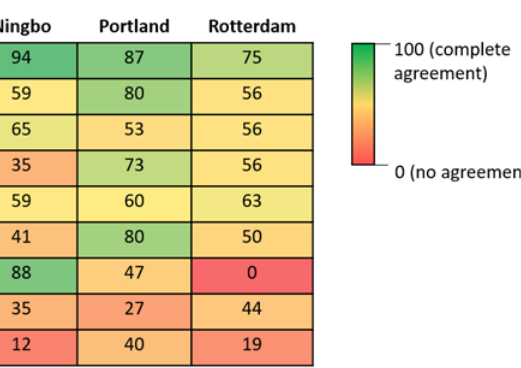
Figure 4. The level of agreement between respondents in each city regarding the perception that the benefits of BGI (Blue-Green Infrastructure) are very important or important. Values range from 0 (red, which indicate that no members of the city group found the benefit to be very important or important) to 100 (green, which indicate that all members of the city group found the benefits to be very important or important). RWH = Rainwater Harvesting.